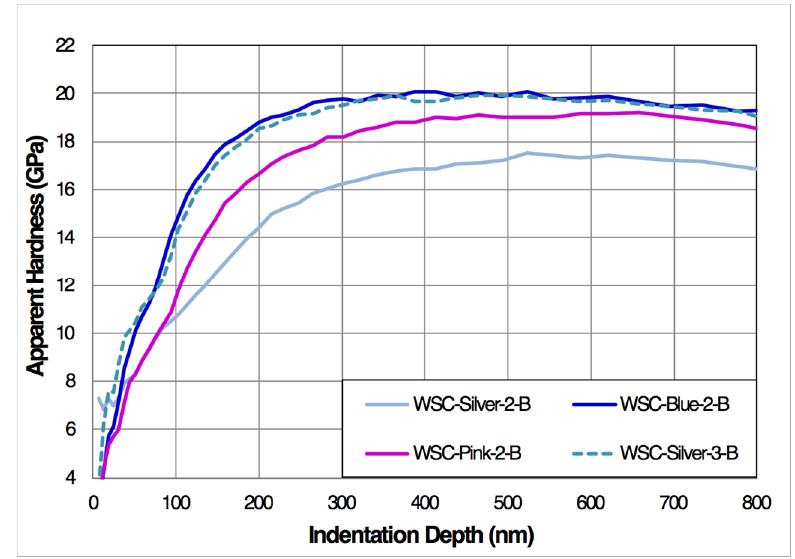
Figure 6. Measured nanoindentation hardness vs. indentation depth for Design Strategy 2 hard coatings. These designs use a “buried active layers” approach to maximize hardness in the 200–800 nm depth range, which leads to excellent scratch resistance. Table 2. Summary of key coating mechanical properties for Design Strategy 2 coatings.